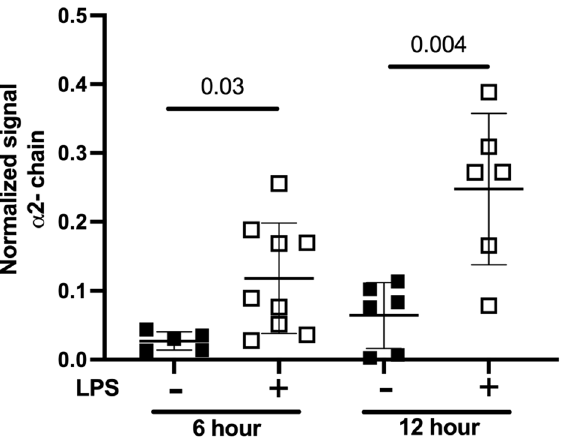
Figure 6. Mouse serum Haptoglobin (HP) α-2 chain, semi-quantification using Western Blot in Ztm. Filled squares—Ztm vehicle-injected; Open squares—Ztm LPS-injected. Unpaired Student t test, p <